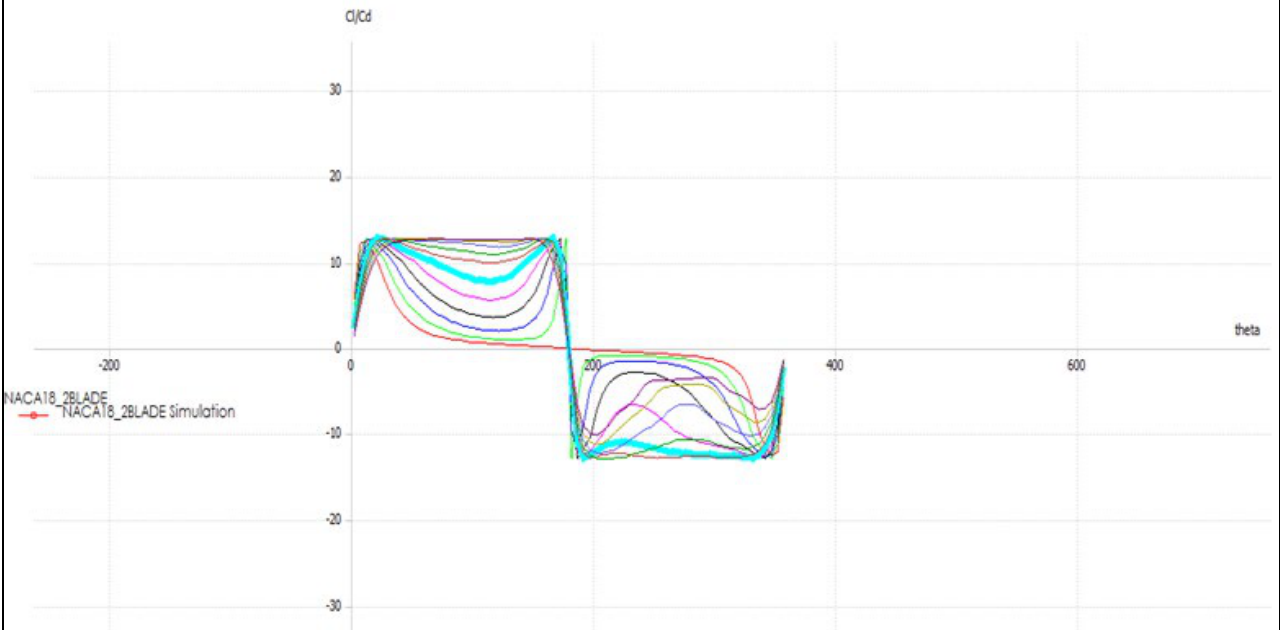
Fi gure 11. Cl/Cd vs theta plot of mid-section for TSR